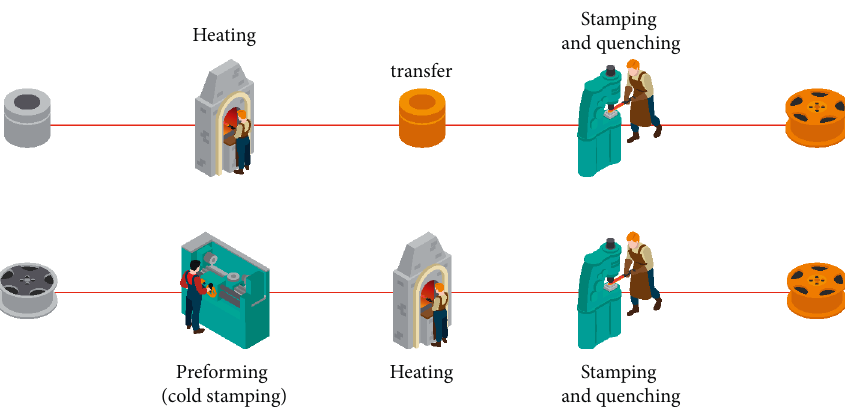
Figure 1: The process of stamping and forming AZ series magnesium alloys by different